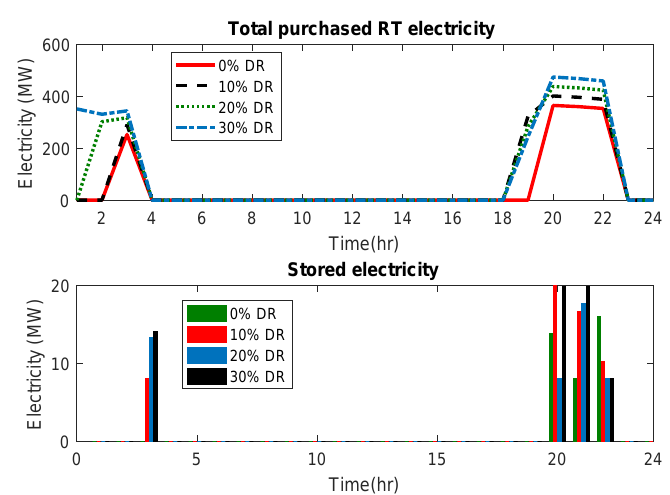
Figure 8. The power purchased from the real-time electricity market.